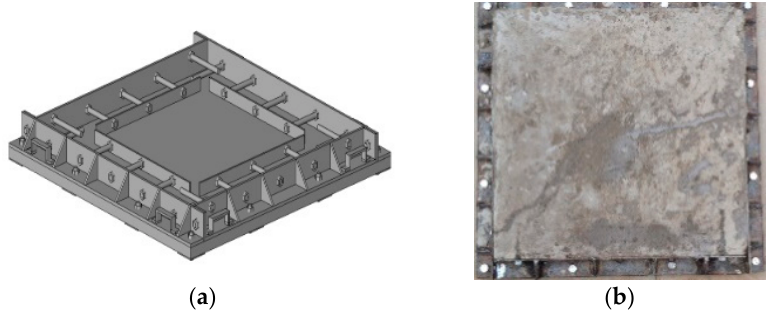
Figure 4. ( a ) The setup apparatus and ( b ) Casted concrete slab with external restraint.